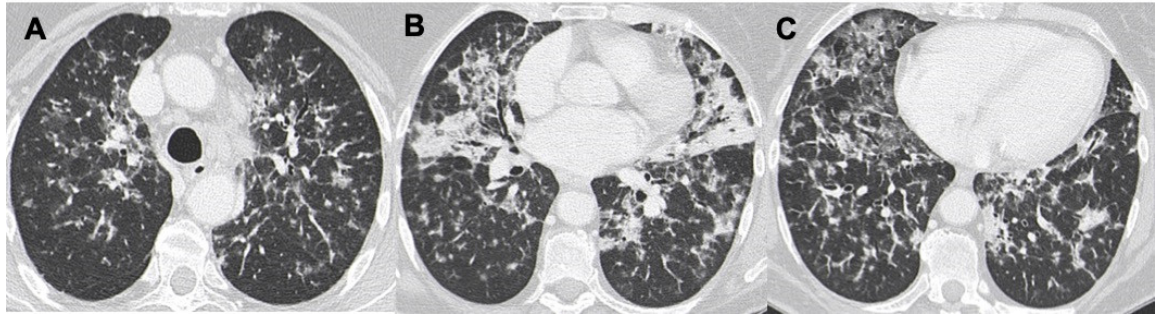
Figure 5. Diffuse interstitial lung involvement in MALT lymphoma. HRCT scans in ( A – C ) show diffuse thickening of the interlobular septa, together with peri-lobular ground-glass opacities and small confluent consolidations.